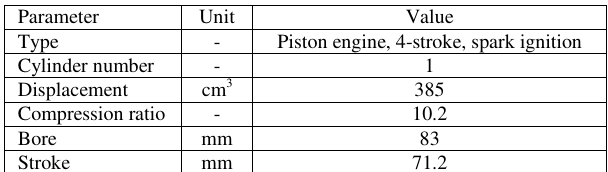
Table 1. Modeled engine technical data